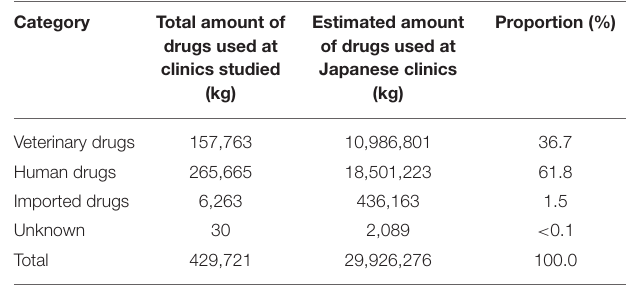
TABLE 3 | Amounts of various antimicrobial drugs used annually at the companion animal clinics studied and estimated amounts used at Japanese clinics, by drug